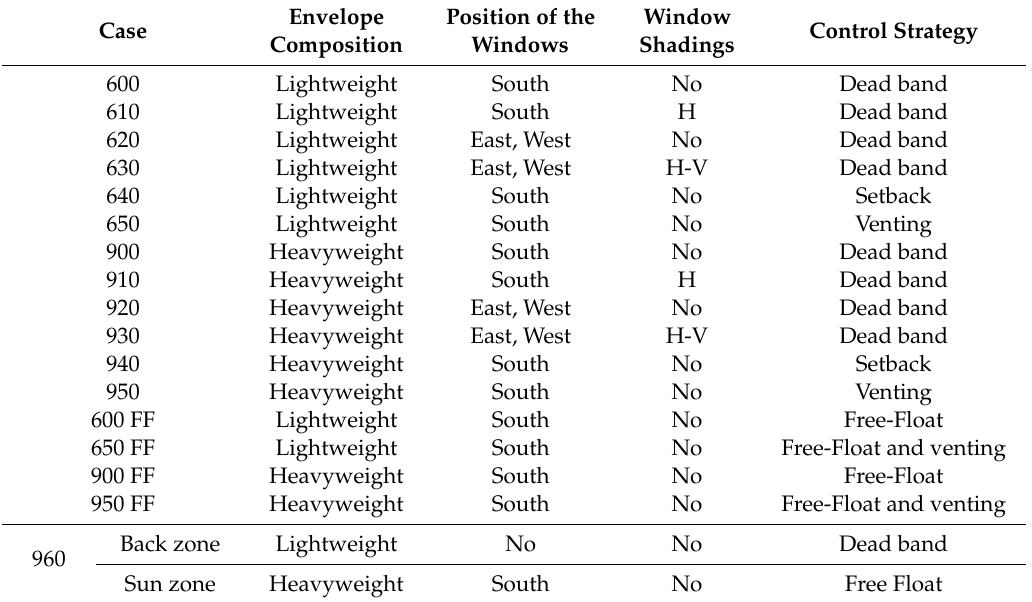
Table 1. List of the qualification cases analysed during the comparative